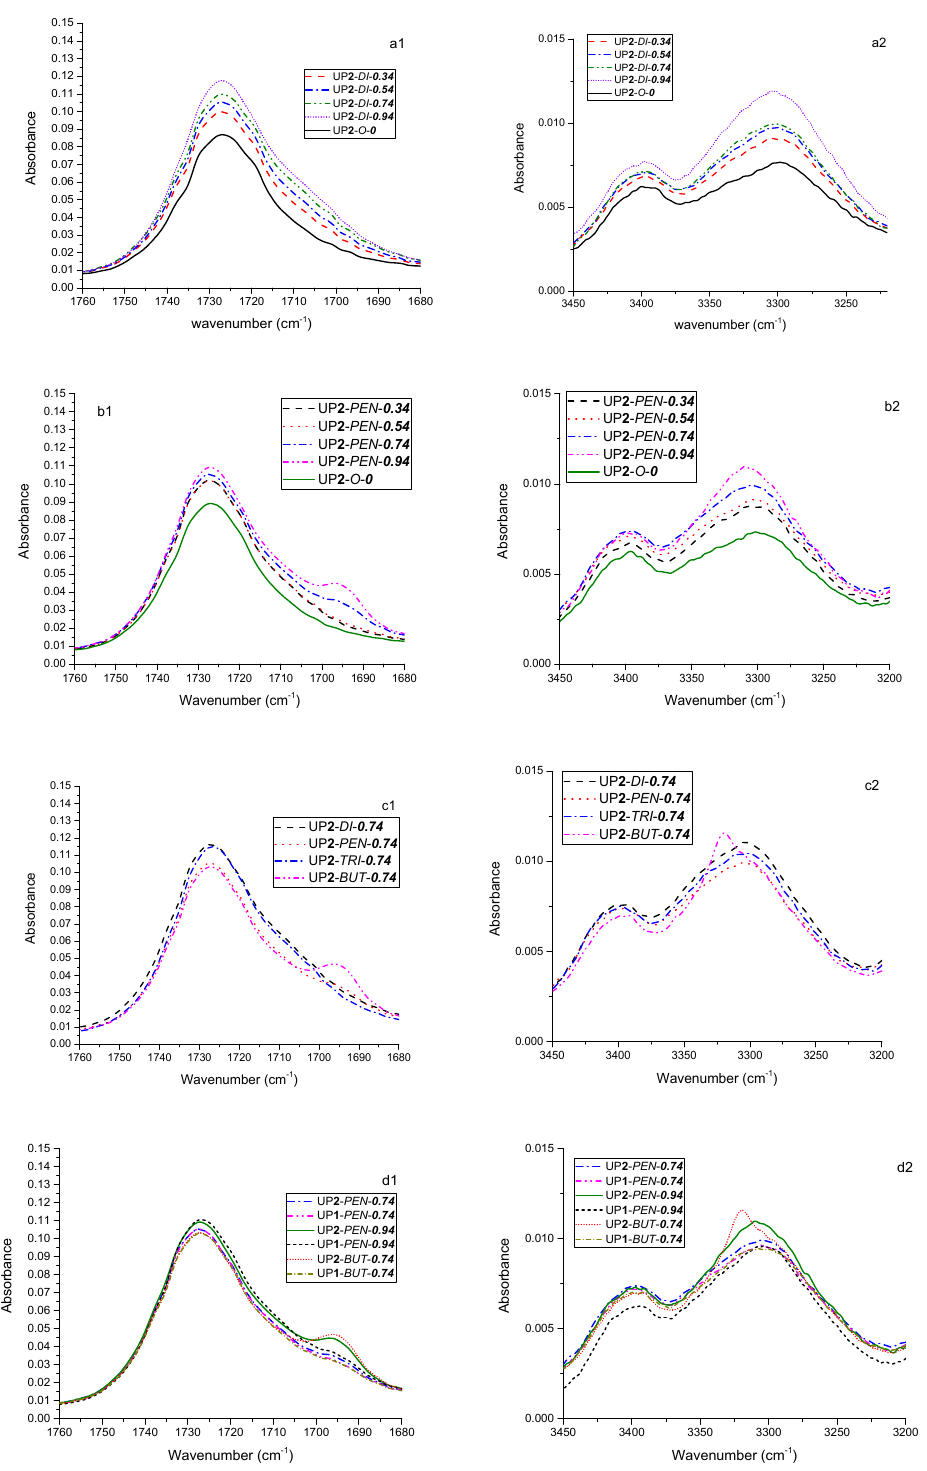
Figure 7. Comparison of ATR-FTIR spectra at the C=O stretching band ranging 1680–1760cm − 1 (left) and N-H stretching band ranging 3200–3450 cm − 1 (right): ( a1 , a2 ) samples prepared by the two-stage process with varying di-PPG amount compared with the blank sample UP 1 - O - 0 ; ( b1 , b2 ) samples prepared by the two-stage process with varying pentanediol amount compared with the blank sample UP 1 - O - 0 ; ( c1 , c2 ) samples prepared by two-stage process with 0.74 molar ratio of different chain extenders; ( d1 , d2 ) selected samples prepared by the two different synthesis processes.